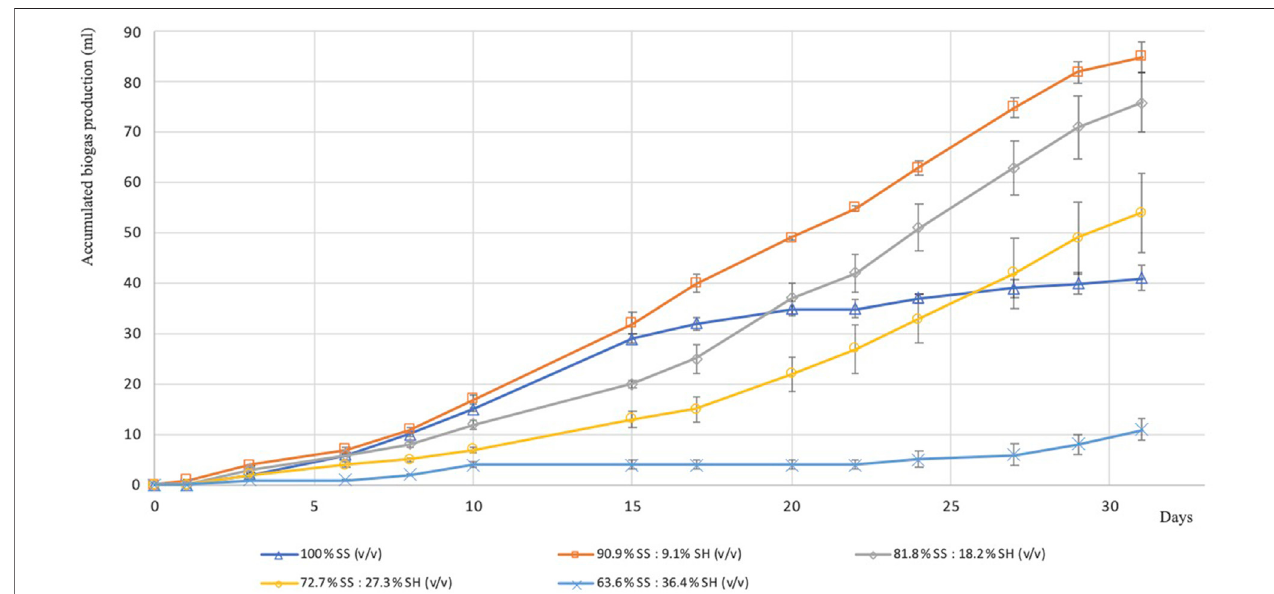
FIGURE 4 | Effect of the SS:SH proportion on biogas production (feed volume (cid:1) 11 ml).